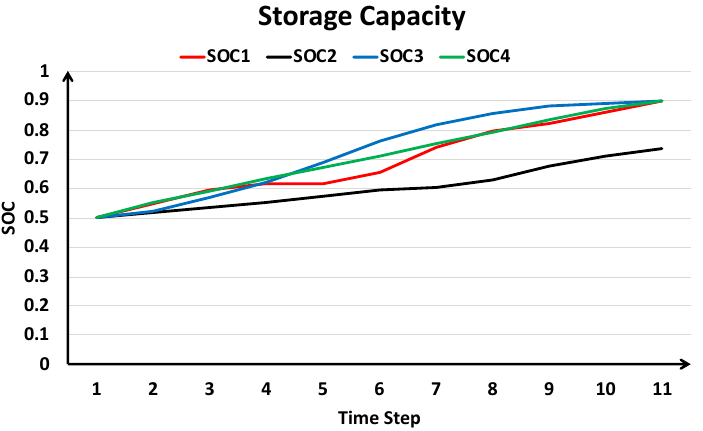
Figure 15. Change of SOC in time when power generators generate lower limits and power loads consume upper limits.